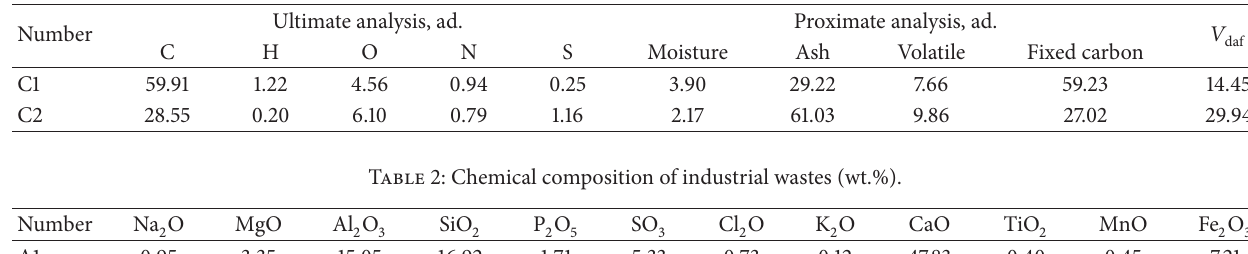
Table 1: Ultimate and proximate analysis (wt.%) of coal samples.